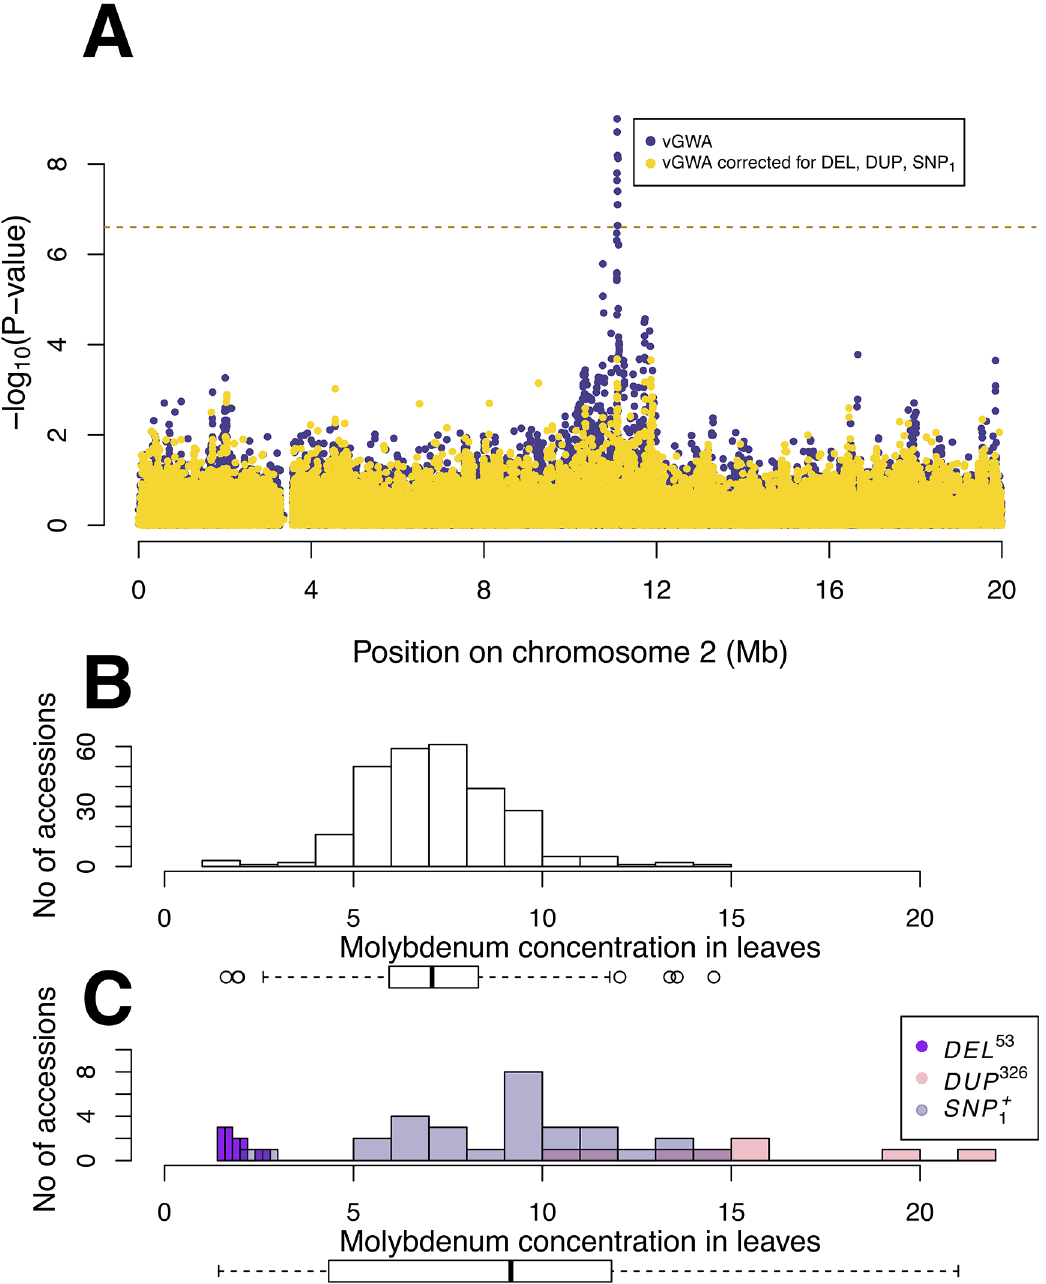
Fig 3. The genetic variance-heterogeneity across vBLOCK emerges from a multi-locus, multi-allelic genetic architecture. (A) The vGWA analysis using the alternative DGLM approach also detects a strong association near MOT1 on chromosome 2 (blue dots). The genetic variance-heterogeneity at this locus is, however, cancelled when the mean effects of the DEL 53 , DUP 326 and SNP 1+ alleles are included in the DGLM model (yellow dots). The variance in the mean leaf molybdenum concentrations is lower for the group of accessions carrying the low-variance associated variant of vBLOCK ( vBLOCK lv ) ( B ) than for the group of accessions carrying the high-variance associated variant ( vBLOCK hv ) (C) . Separate colors are used for the accessions carrying the DEL 53 (purple), DUP 326 (red) and SNP 1+ (grey) alleles in (C) to illustrate how these alleles generate the high variance in mean leaf molybdenum concentrations associated with vBLOCK hv